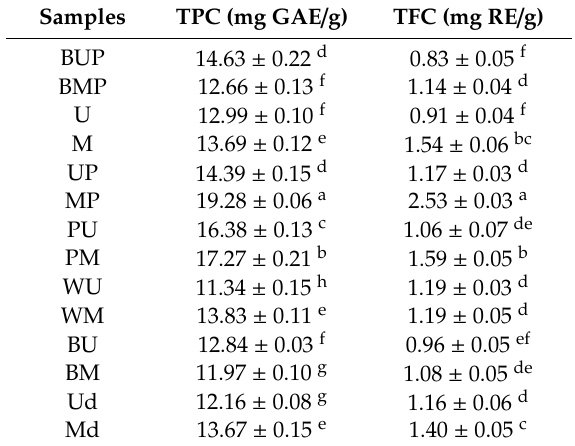
Table 4. Total phenolic and flavonoid contents in the strawberry samples *